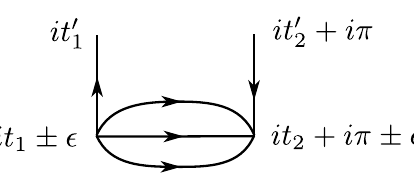
Figure 7 . The retarded kernel. Retarded propagators go along rails, and the left-right propagator goes between